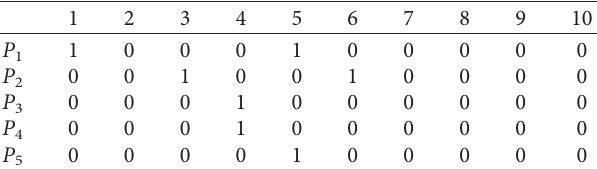
Table 4: Demand of bins per